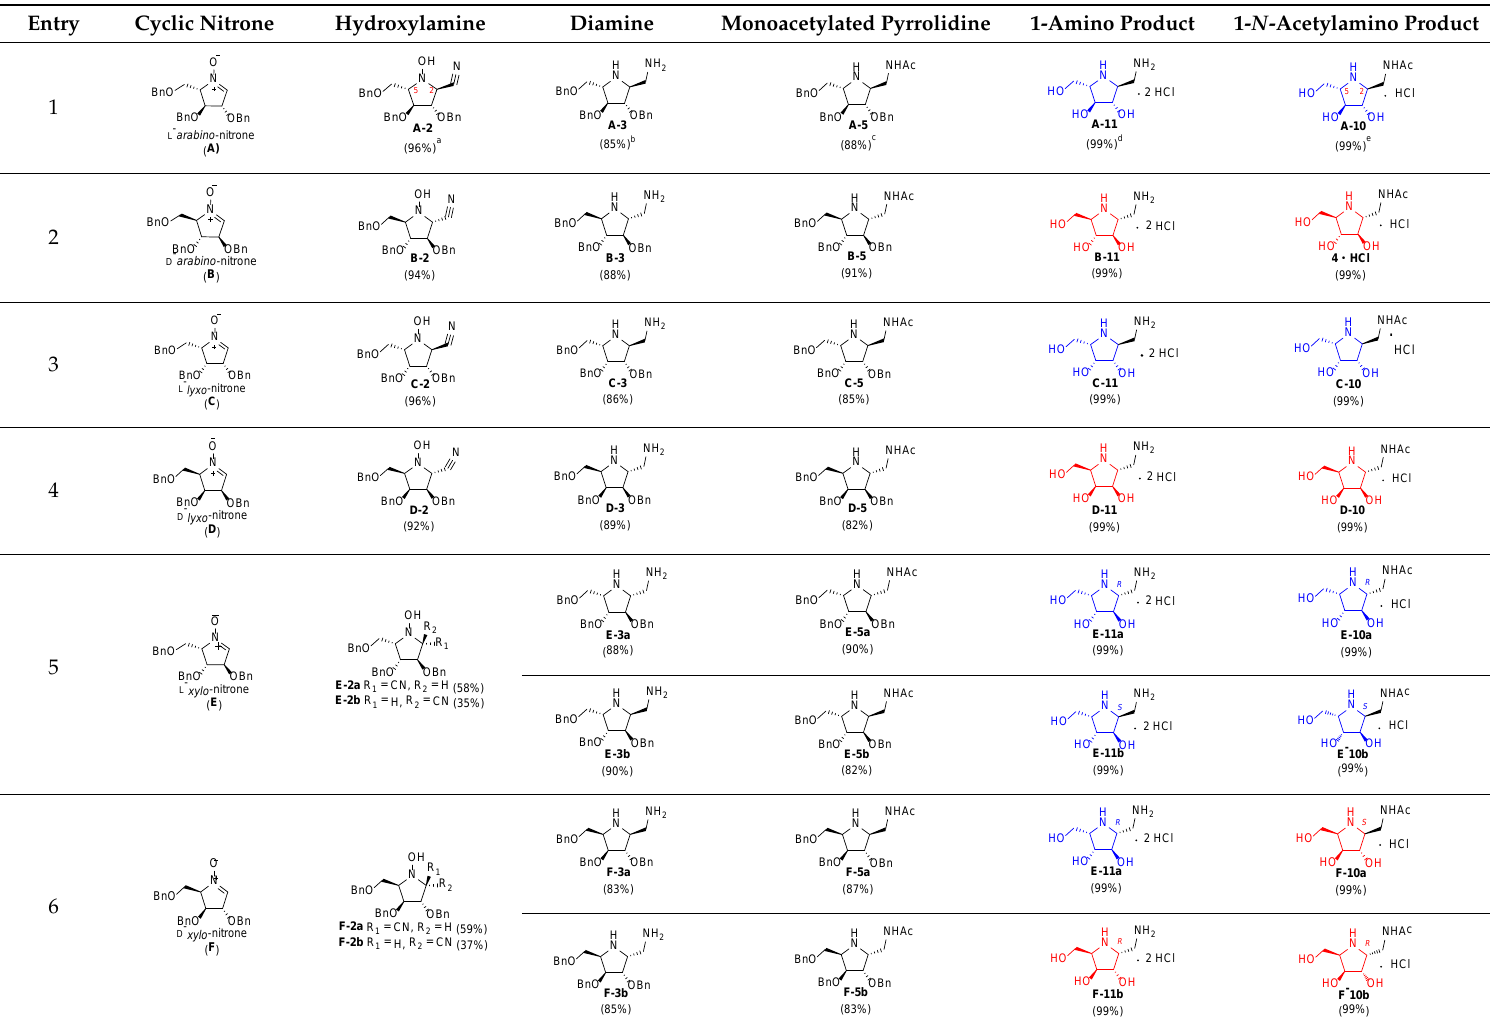
Table 1. 1-Amino and 1- N -acetylamino pyrrolidine analogues synthesized from cyclic nitrones. Entry Cyclic Nitrone Hydroxylamine